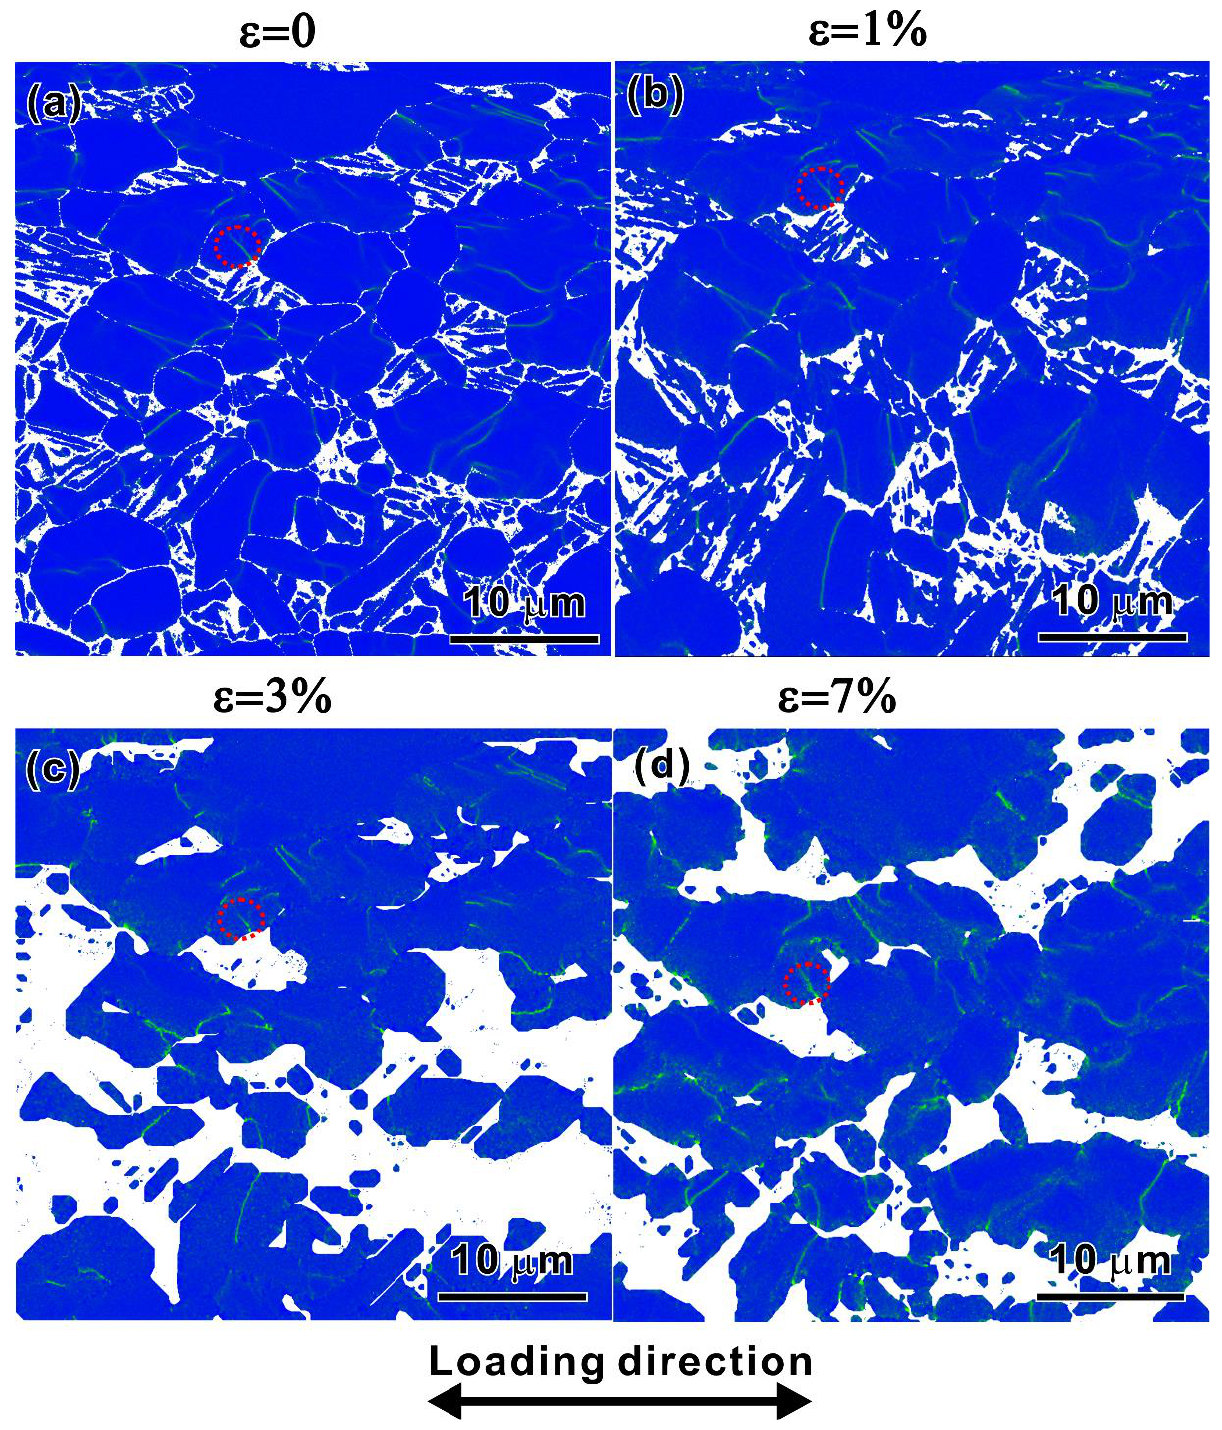
Figure 9. GND density mapping based on the EBSD data with strains of ( a ) 0%; ( b ) 1%; ( c ) 3%; and ( d ) 7%, respectively.